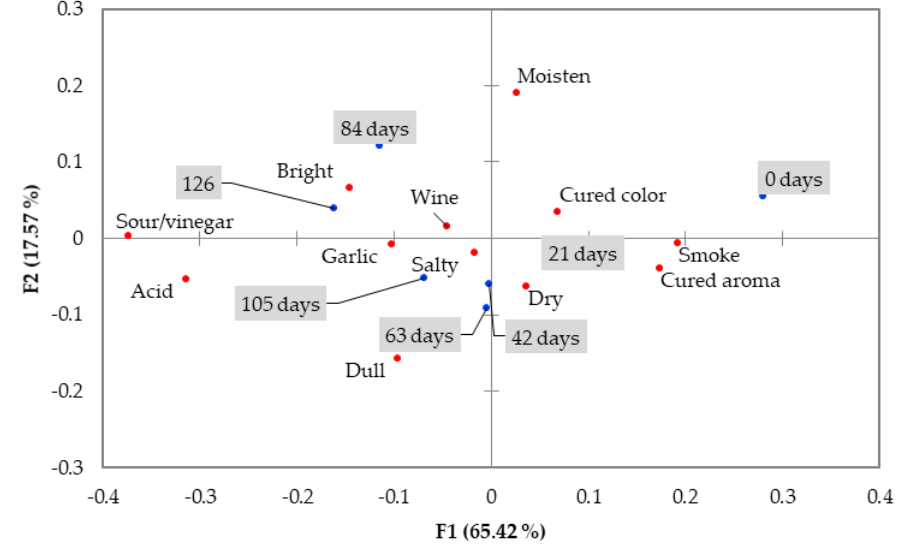
Figure 3. Attributes of cured loins and di ff erent storage durations tested (grey boxes) in the space defined by the first two factors.